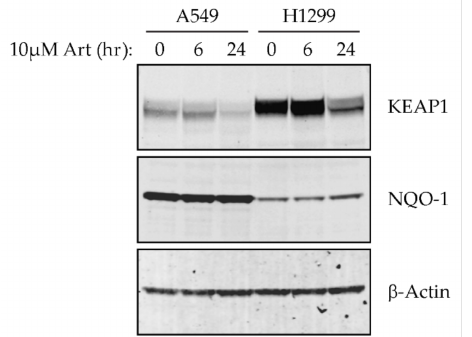
Artesunate treatment induces changes in kelch-like ECH-associated protein 1 (KEAP1)/nuclear factor erythroid 2-related factor 2 (NRF2) pathway protein expression in a time- dependent manor in A549 and H1299 NSCLC cell lines. Cells were treated with 10 µ M artesunate for 0, 6, or 24 h and levels of KEAP1 and NQO-1 (NAD(P)H quinone dehydrogenase 1) proteins were assessed by Western blot. In both cell lines, KEAP1 protein levels are reduced following treatment with artesunate. The original blots can be found at Figure